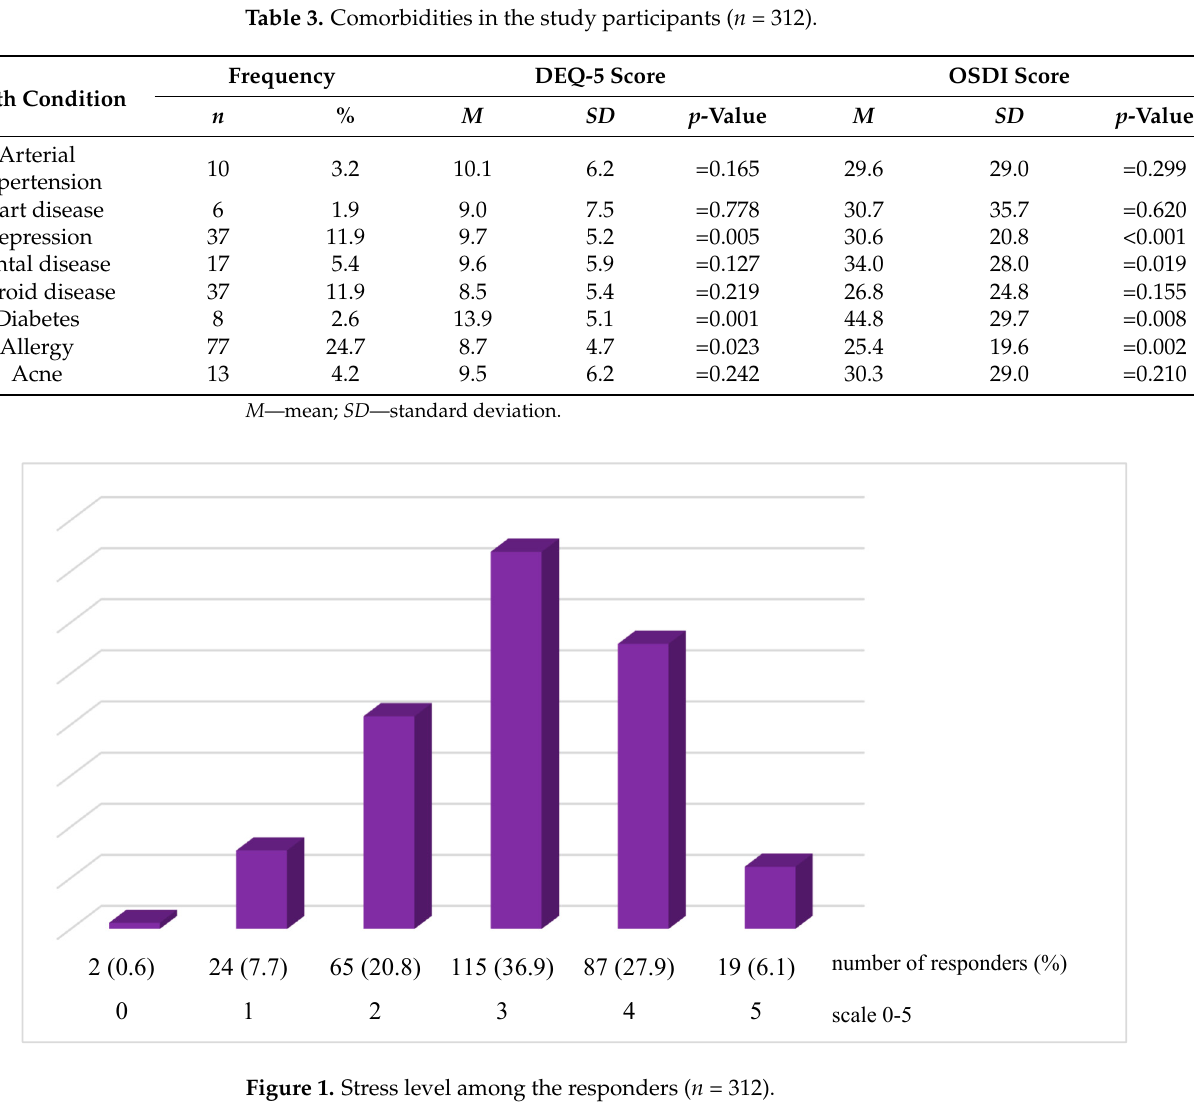
Table 2. Medication taken chronically by the study participants ( n = 312).